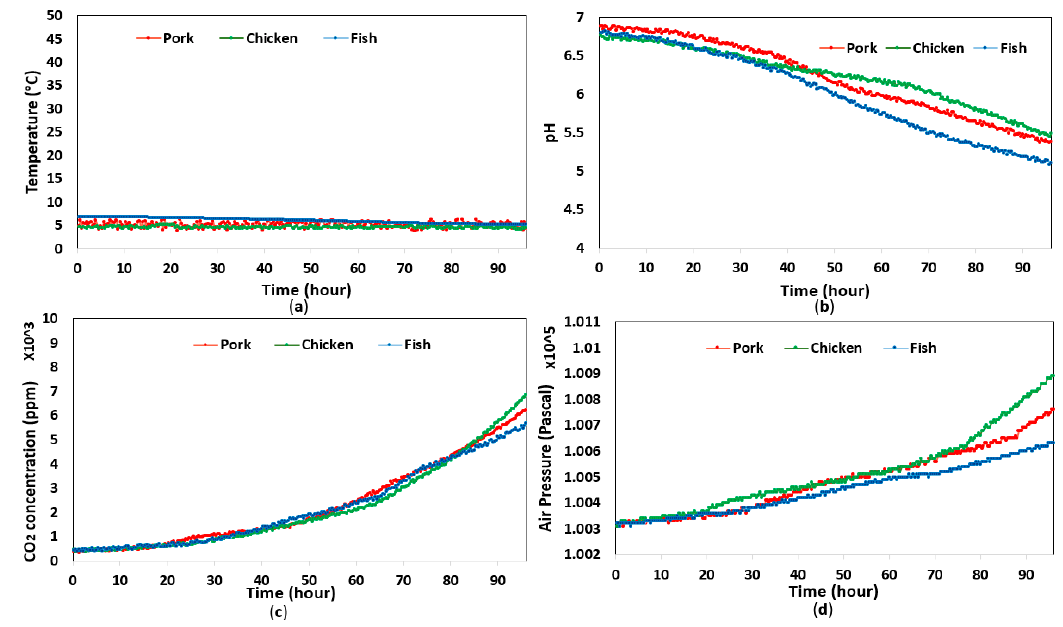
Figure 4. Experimental results with tested food in refrigerated conditions for 4 days: ( a ) temperature; ( b ) pH; ( c ) CO 2 concentration; ( d ) headspace pressure.